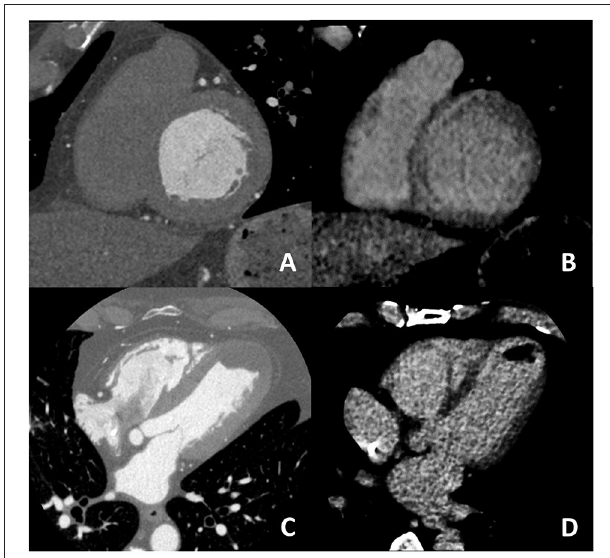
FIGURE 6 | In (A,B) an example of non-ischemic fibrosis on the interventricular septum is shown; more specifically, in (A) angiographic phase CT is presented with corresponding late CT acquisition well demonstrating non-ischemic mid-wall myocardial fibrosis in (B) . In (C,D) a case of ischemic cardiomyopathy is presented; an apical left ventricular thrombus is evident both at first pass CT (C) and at late phase CT (D) from which the ischemic subendocardial fibrosis could be